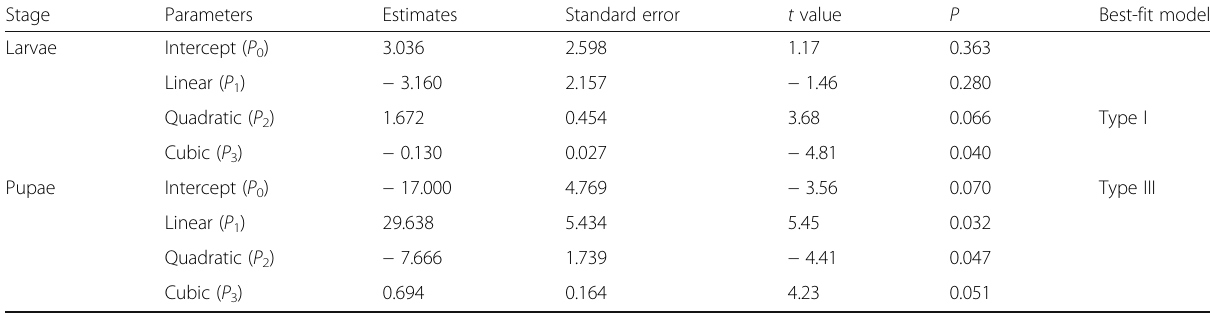
Table 3 Maximum likelihood estimates from logistic regression of the proportion of P. truncatus larvae and pupae eaten by A. biannulipes as a function of initial prey density